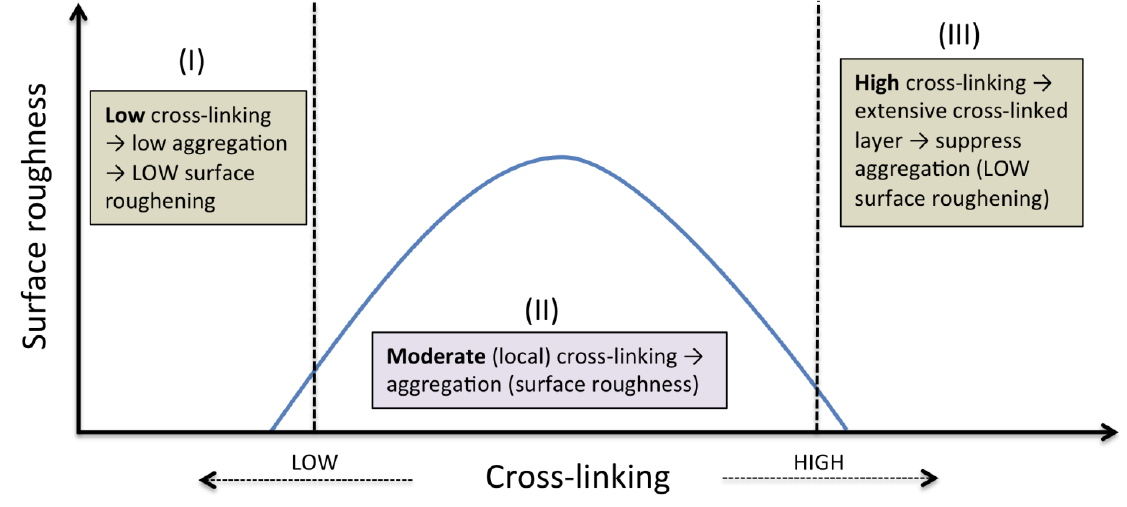
Figure 9. Cross-linking induced aggregation model of formation of surface roughness during plasma etching of